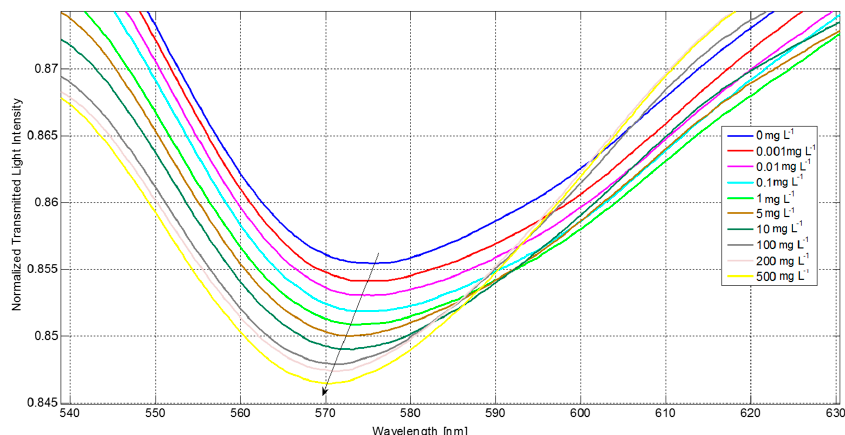
Figure concentrations in buffer.